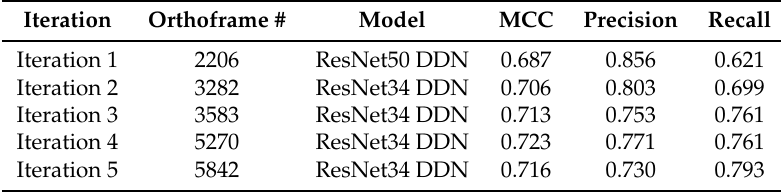
Table 4. Defect detection metrics for the test set over iterations.